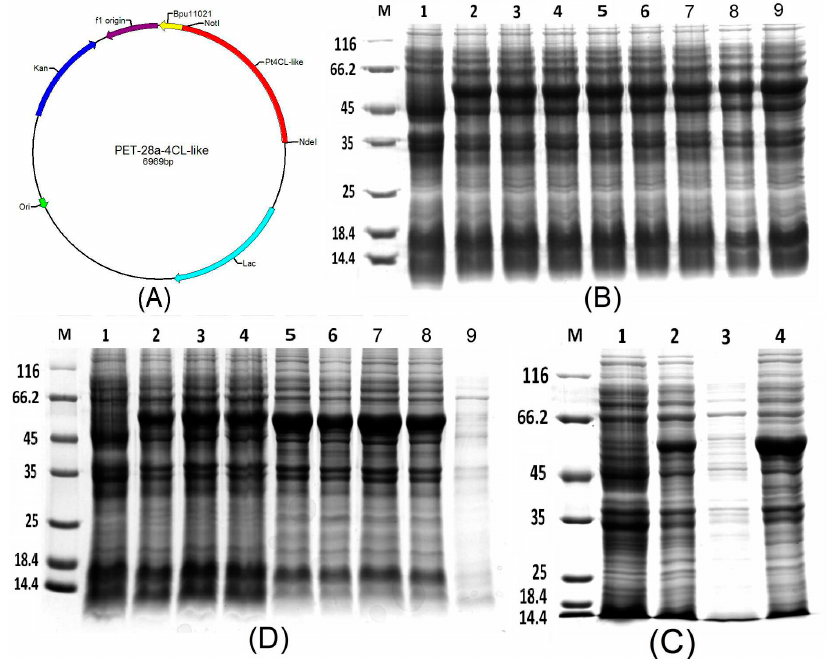
Figure 4. Construction of the prokaryotic expression vector for PET-28a- Pt4CL-like and analyses of the expressed fusion protein through 12% polyacrylamide gel electrophoresis (SDS-PAGE). ( A ) Construction of the prokaryotic expression vector for PET-28a- Pt4CL-like , using Nde I and Not I as the two restriction enzymes. ( B ) Analyses of the expressed fusion protein through 12% SDS-PAGE. Lane